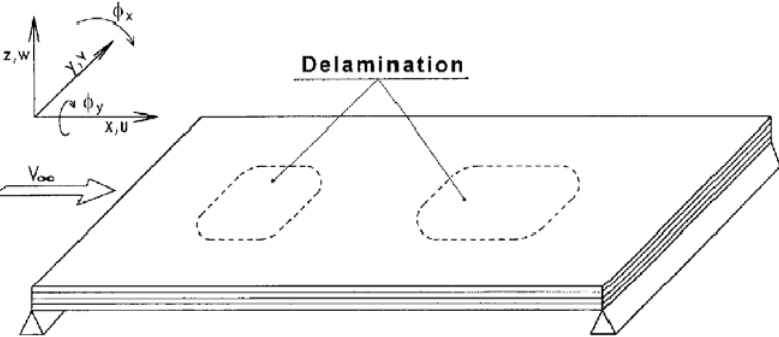
Figure 3. Multi ‐ layer composite plate with delamination, Adapt with permission from [46]. Figure 3. Multi-layer composite plate with delamination, Adapt with permission from